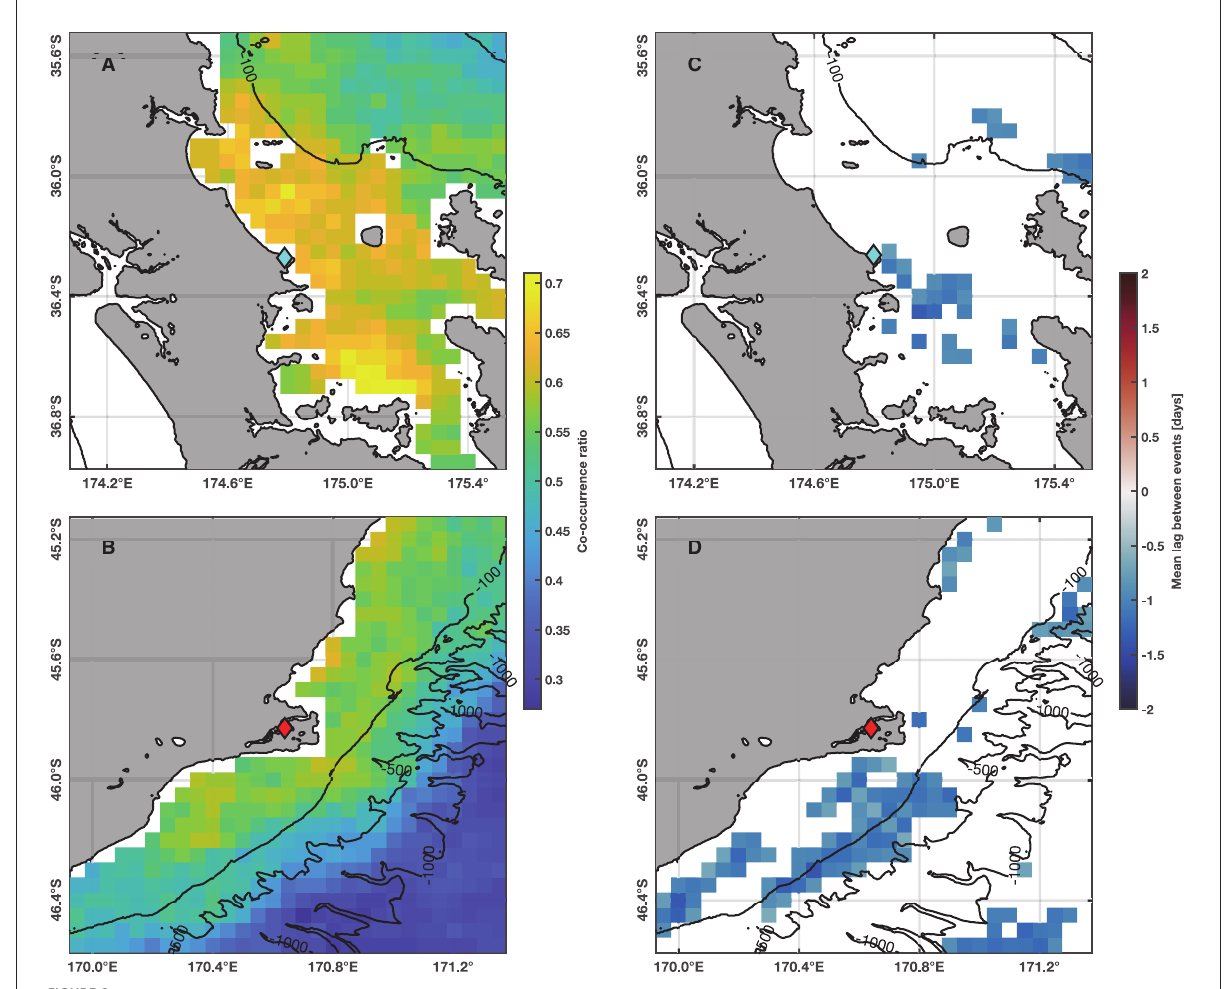
FIGURE6 Maps of MHW co-occurrence ratios (fraction of MHWs at study site that a co-occurring MHW at coastal grid cell) between MHWs detected at coastal stations and MHWs at grid cells in the coastal ocean for (A) Leigh and (B) PML. The significant mean lag between MHWs detected at the coastal stations and in the coastal ocean are shown in (C,D) . Blue (red) indicates that for co-occurring events, MHWs in the harbor precede (follow) events in the coastal ocean. Also shown is the regional bathymetry with the coastal stations located at the blue (Leigh) and red (PML) diamonds on the